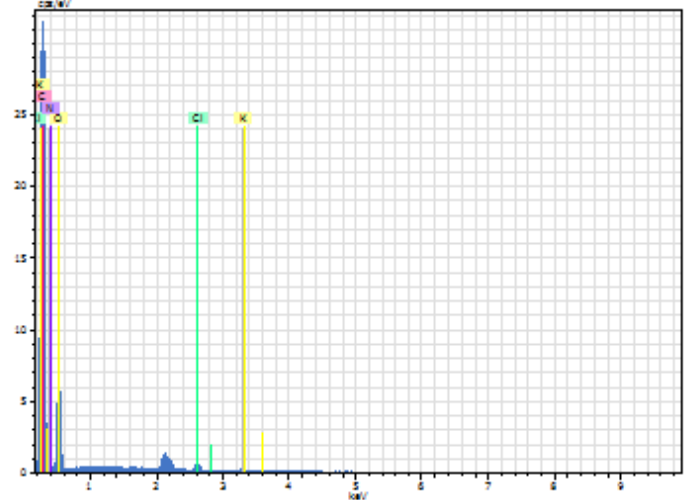
Figure 28. Elemental analysis of epoxy resin sample at 1000 rpm.